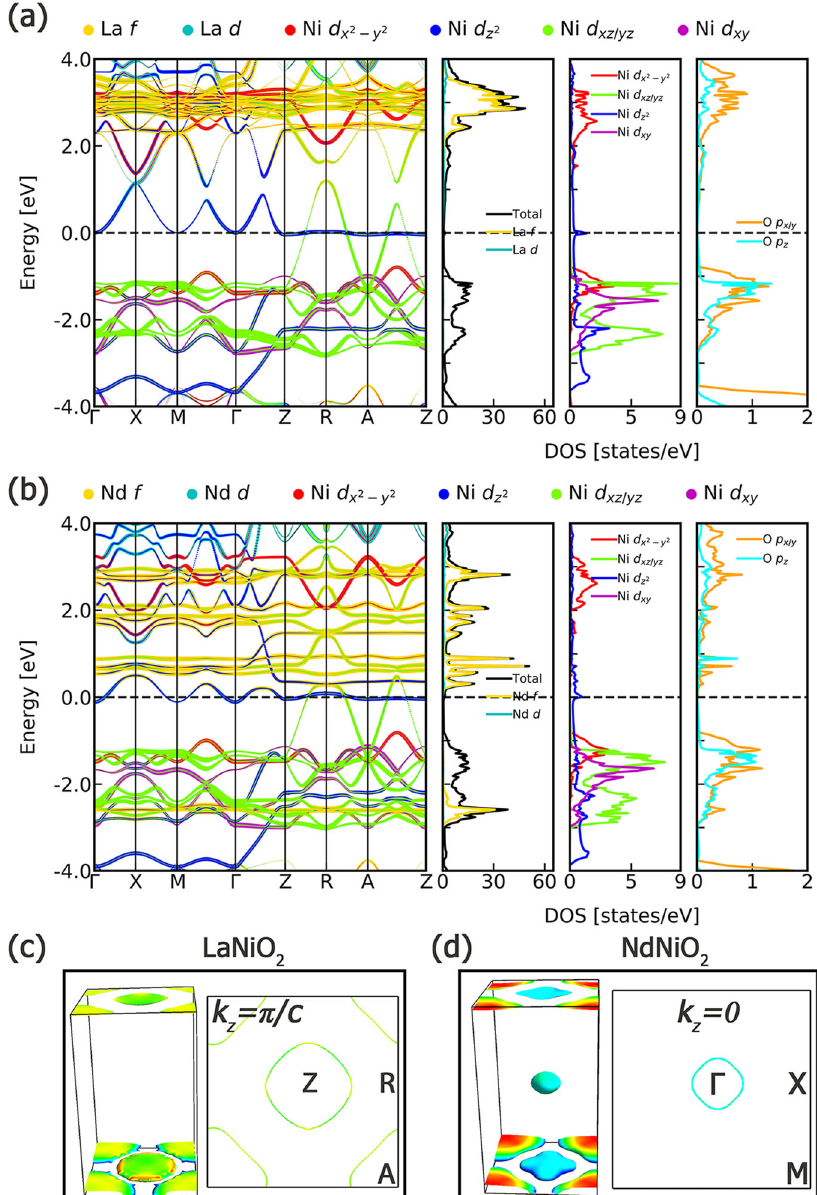
Fig. 3 The calculated electronic structures and Fermi surfaces of C -type antiferromagnetic ( C -AFM) phase. Orbitally-projected electronic structures of C -type antiferromagnetic phase of a LaNiO “ unfolded ” on to the primitive 1 × 1 × 1 Brillouin zone. c The calculated Fermi 2 and b NdNiO 2 . Band structures are surface of LaNiO 2 and the projection of the Fermi surface on the k z = π / c plane. d Same as c but for NdNiO 2 . Red and blue colors identify portions of the Fermi surface where the Fermi velocity is maximum and minimum, respectively. The Fermi velocity lies in-between the maxima and minima in the green